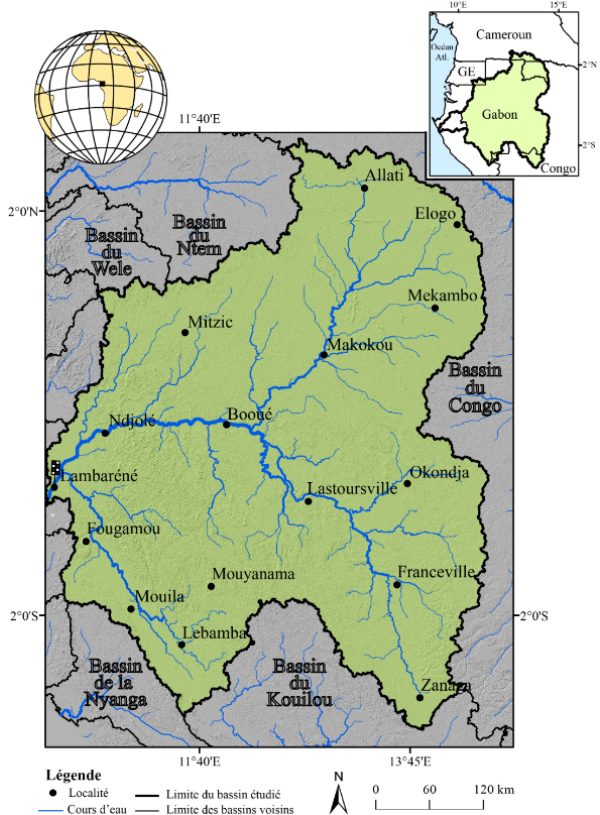
Figure 1. Localisation du bassin versant de